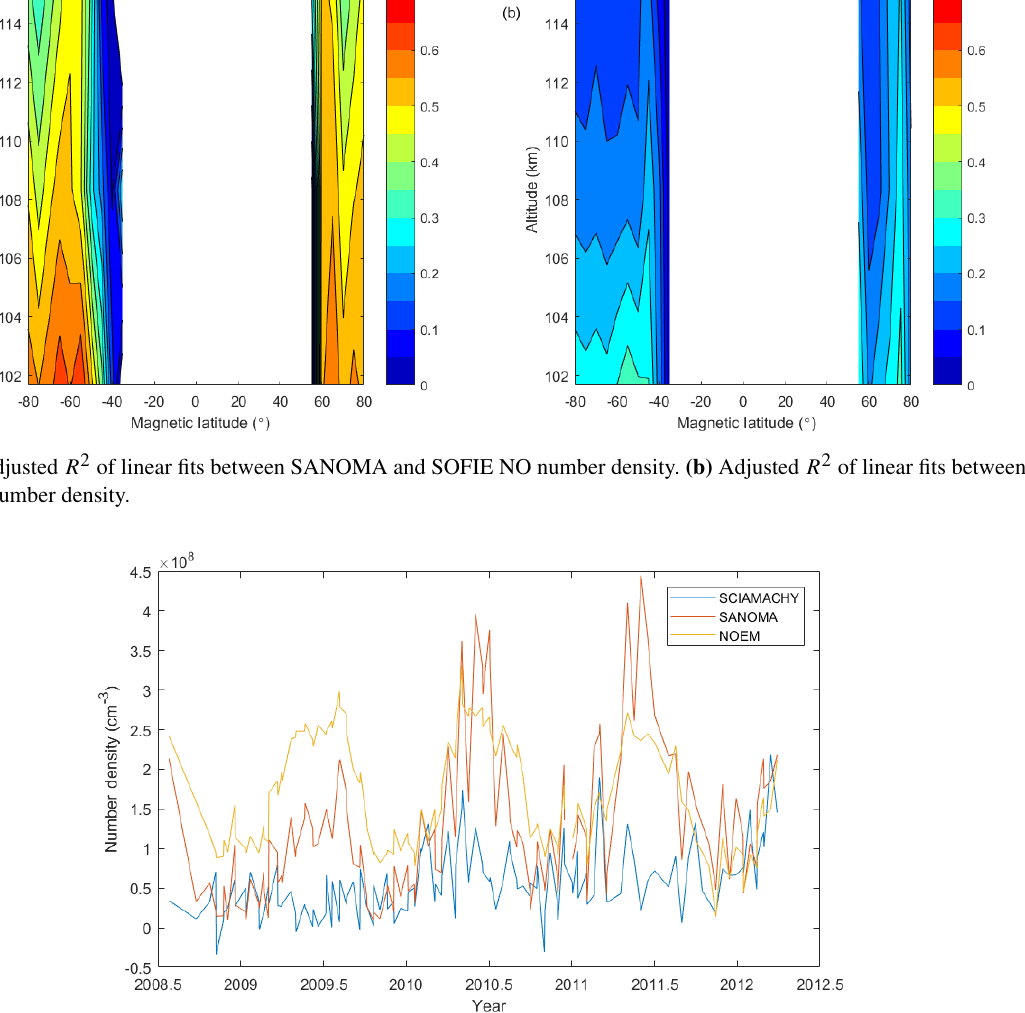
Figure 16. Time series of NO number density measured with SCIAMACHY and simulated with SANOMA as well as NOEM, 102km altitude, − 70 ◦ (cid:51)